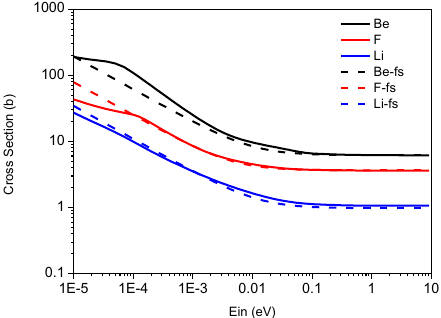
Fig. 9. Thermal neutron scattering cross sections for F, Li, Be at